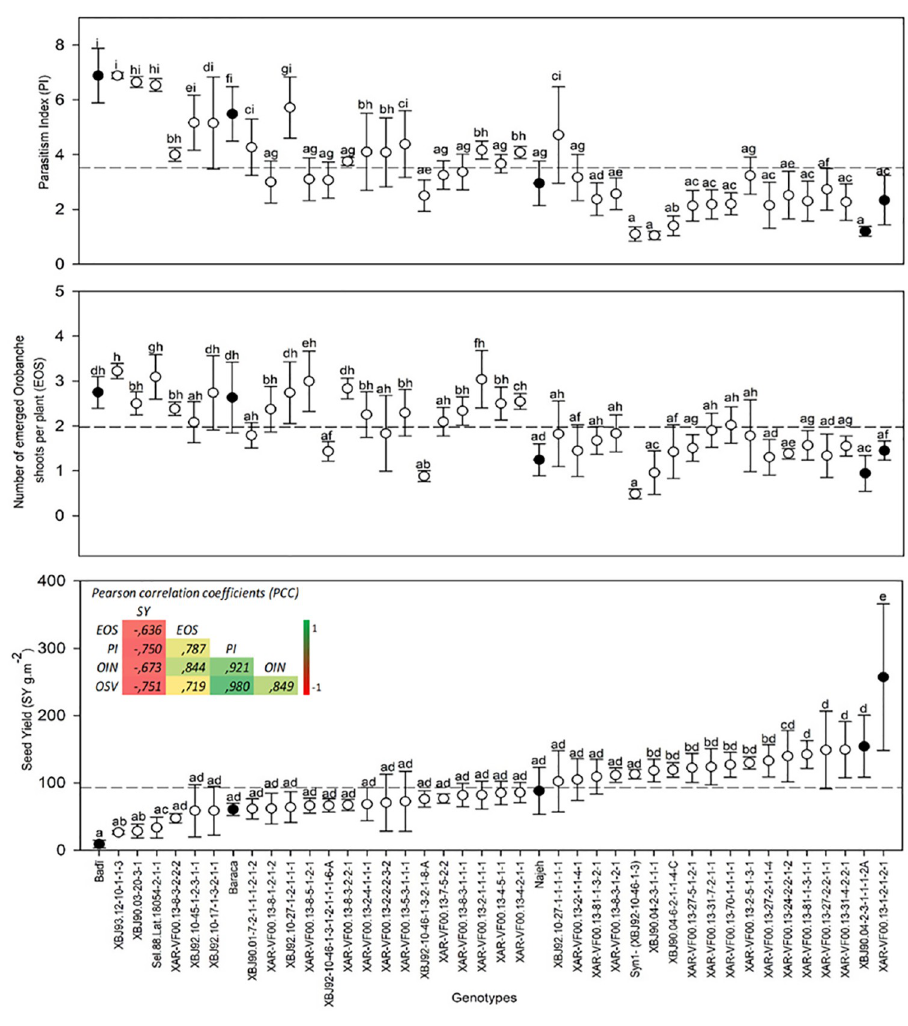
Fig 1. Najeh. High negative correlation between SY and both EOS (r = - 0.636, P � 0.001) and PI (r = - 0.770, P � 0.001) was observed. Results generated from the second-year evaluation showed high differences ( P � 0.01) between the five studied genotypes for OIN, OSV, DOE, TON, and EOS. High OIN was observed for the two cultivars Badi and Baraca with 81.7% and 85%, respectively (Table 3) against moderate to low OIN observed for Najeh (65%), XAR-VF00.13-1-2-1-2-1 (60%) and XBJ90.04-2-3-1-1-1-2A (40%). Maximum infestation was observed for the susceptible geno- type Badi with 5 attachments per plant against only 1.2, 1.3 and 1.9 attachments observed for Najeh, XAR-VF00.13-1-2-1-2-1 and XBJ90.04-2-3-1-1-1-2A (Fig 2). At crop maturity (early June), EOS varied from 0.9 observed for XBJ90.04-2-3-1-1-1-2A to 2.7 recorded for Badi (Table 3). Only, 1.2, 1.4 and 2.6 shoots per plant were recorded respectively for Najeh,